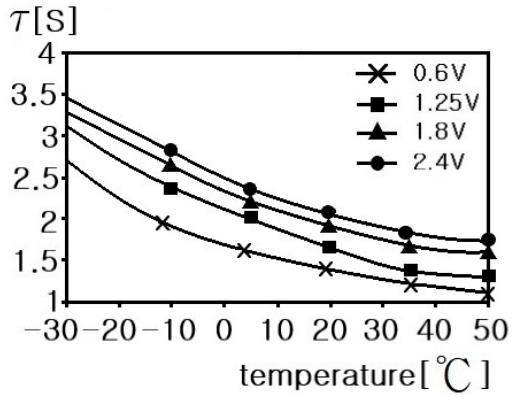
Figure 12. Curve of 𝜏 , which is an independent parameter of temperature and voltage in super- capacitors.